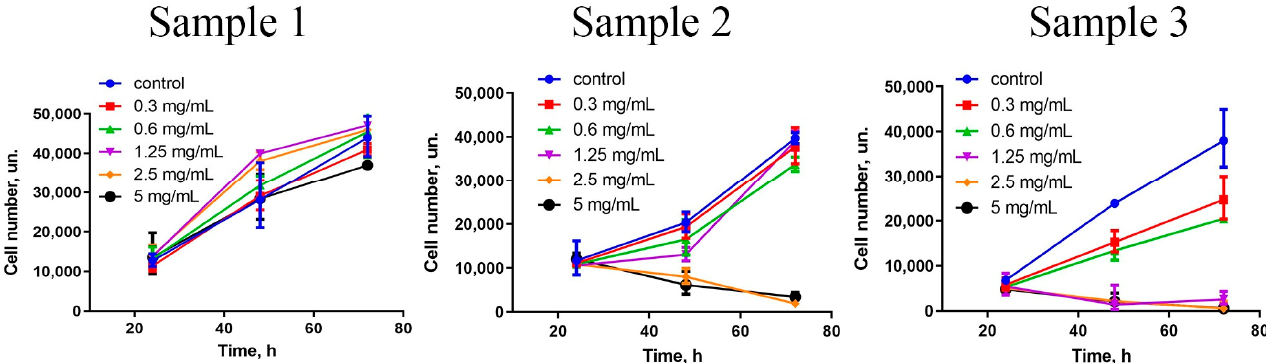
Figure 4. Growth curves of mesenchymal stem cells in the presence of various concentrations (0.3– 5 mg/mL) of Ce 0.8 Gd 0.2 O 2 − x nanoparticles during 24, 48 and 72 h of